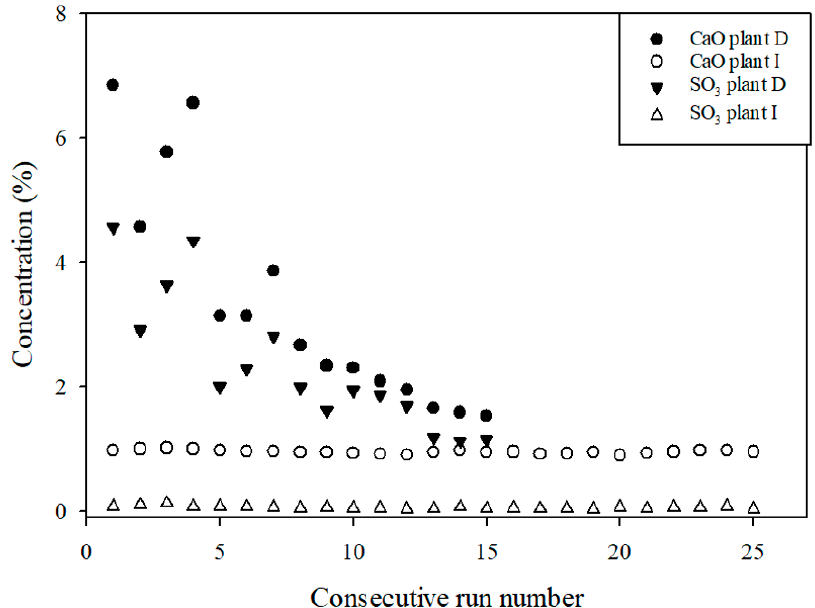
Figure 7. CaO and SO 3 concentrations for the <200-mesh products of consecutive runs of the Plant D and I fly ashes. Note, except for the first five runs for Plant D, the numbers do not correspond to the run numbers in Table